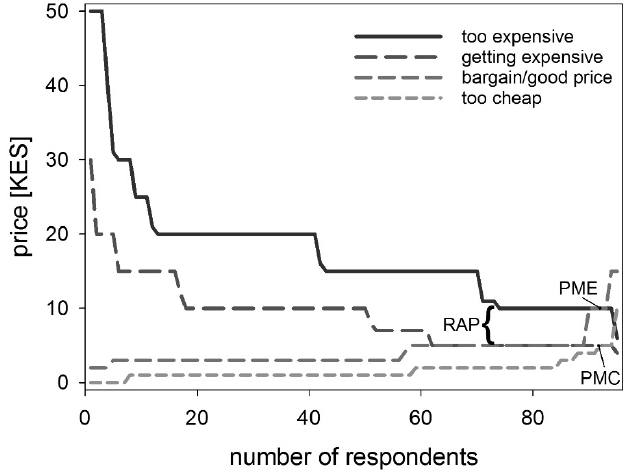
Figure 5. Household expenditure on water per 20 L container: Kangemi Gichagi (urban) ( N = 25), and Ngoliba/Maguguni (rural) ( N = 28) (KES 1 = USD 0.0118). Van Westendorp’s price-sensitivity meter was applied to determine people’s willingness to pay for water. The range of acceptable prices for water was found to lie between KES 5 and KES 10 for a 20 L container. The range between KES 2 and KES 5 was seen to be a good bargain price by 94% of respondents (Figure 6). For this enquiry, respondents were asked about their willingness to pay for safe water from sources that are convenient to access.